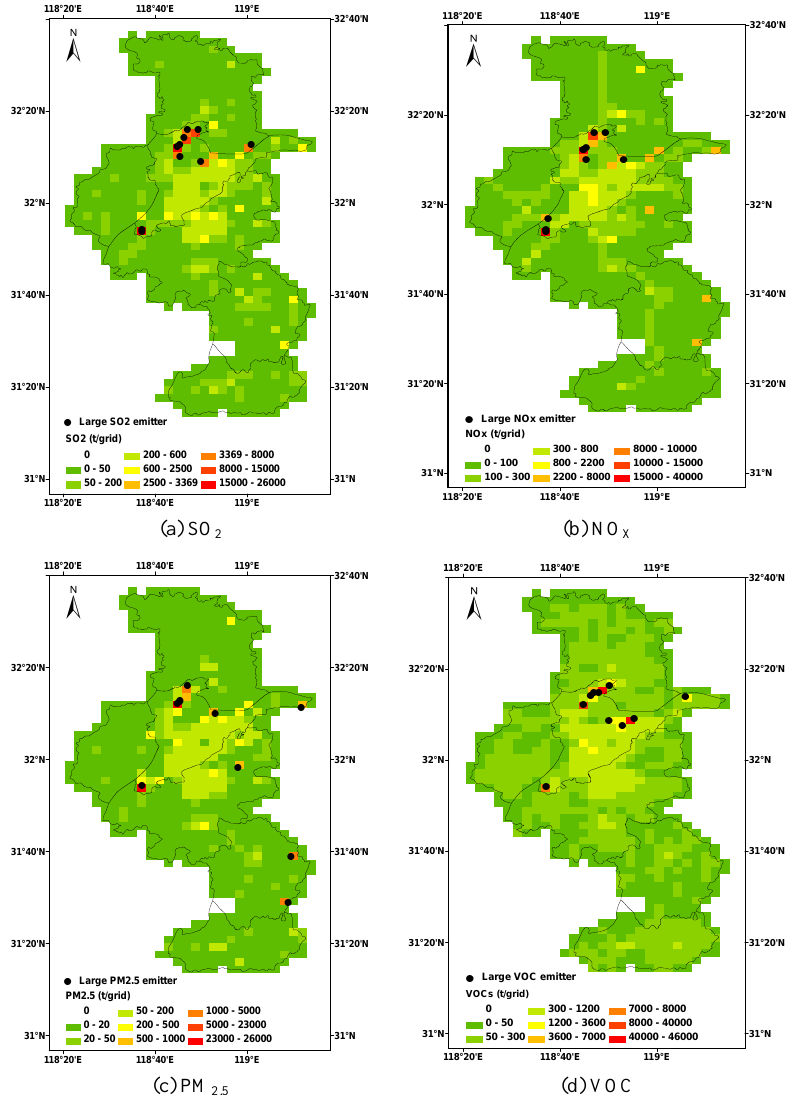
Figure 2. Spatial distribution of emissions for Nanjing 2012, with locations of largest point sources indicated. (a) SO 2 ; (b) NO x ; (c) PM 2 . 5 (fugitive dust from construction and road sources excluded); and (d)